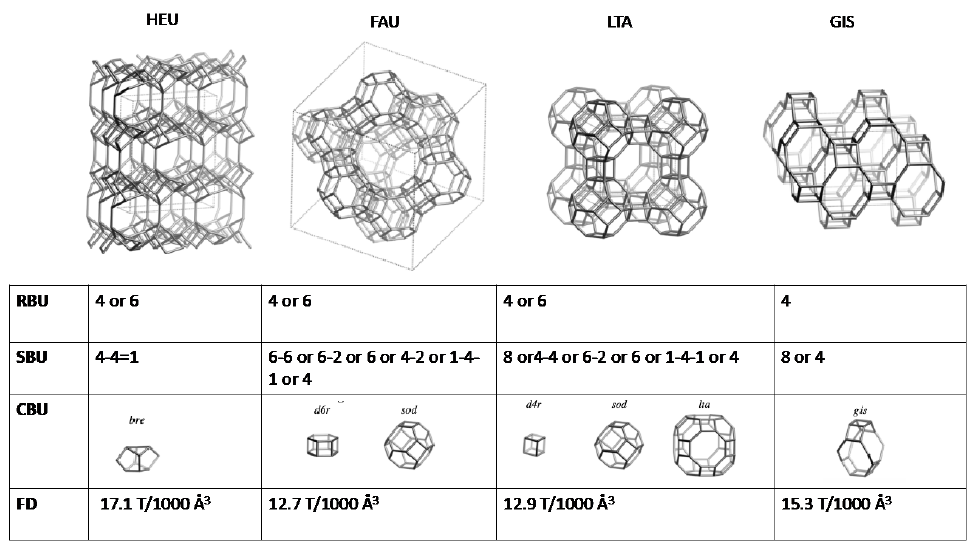
Figure 10. Zeolite HEU, FAU, LTA, and GIS structures with RBU, SBU, CBU, and framework density (data from IZA [39]).